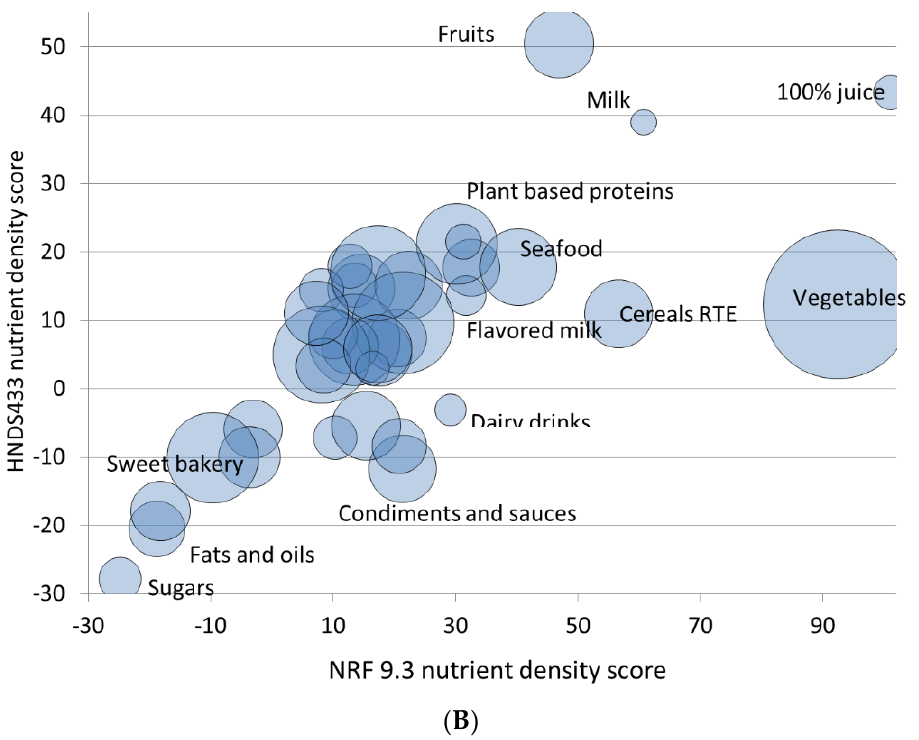
Figure 1. Relation between NRF 9.3 score and NRFh 4:3:3 by ( A ) ( top panel ) WWEIA food group and ( B ) ( bottom panel ) WWEIA food category. Size of the bubble denotes the number of foods within each food group or category.